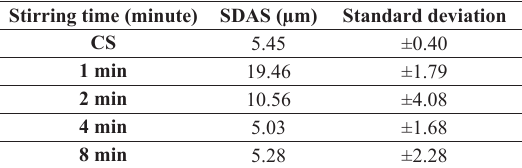
Table 2. Secondary dendritic arm spacing, obtained from the processed samples, for the different stirring times of 1, 2, 4 and 8 minutes, from 6 mm diameter